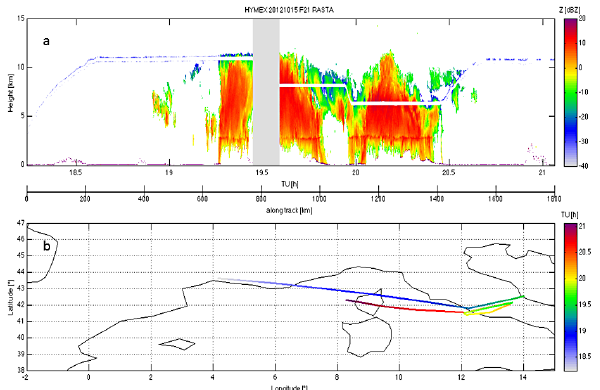
Figure 14. (a) WRF equivalent potential temperature ( ◦ C) and low- level jet at 925hPa; (b) WRF reflectivity at 850hPa (dbz) and wind at 925hPa (WRF-CETEMPS initialized by ECMWF at 12:00UTC, 14 October